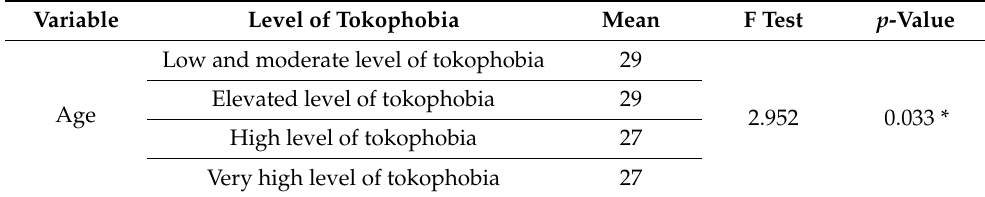
Table 5. The influence of age on the level of tokophobia (n = 315). Variable